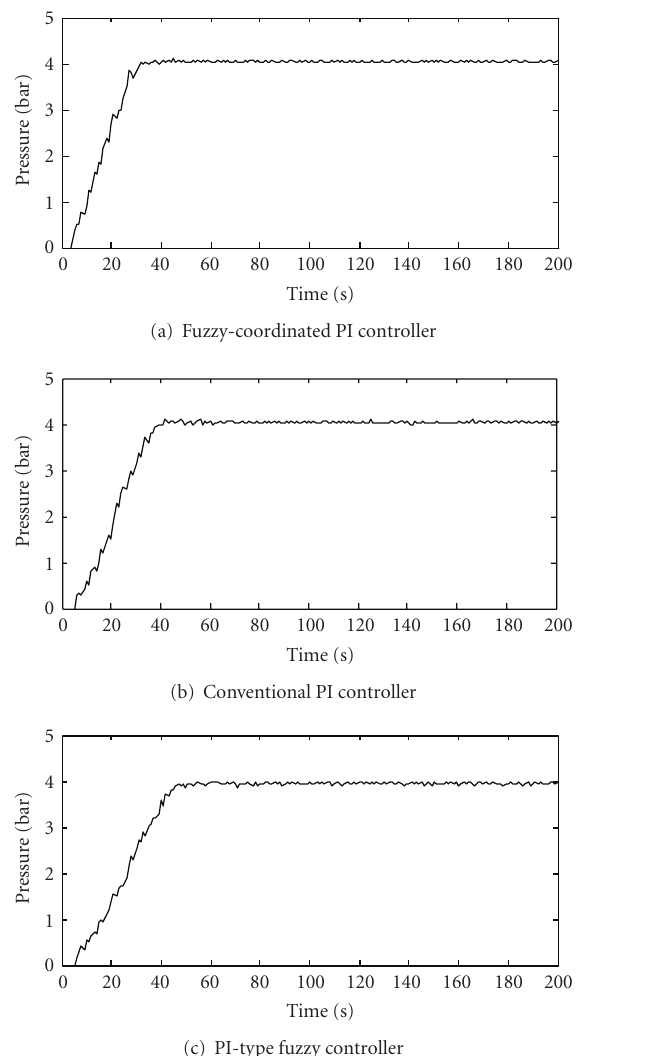
Figure 12: Experimental results, output responses of di ff erent controllers for set point change from 3bar to 4 bar.